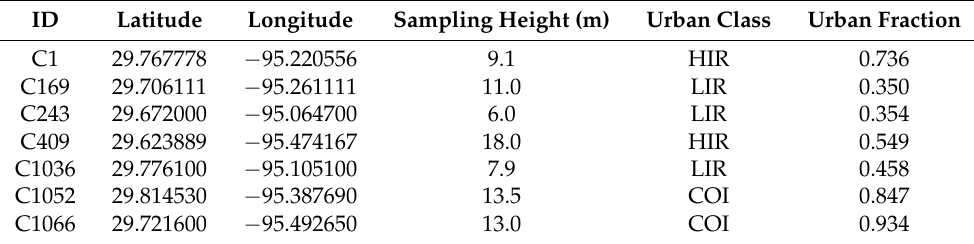
Table 2. TCEQ air monitoring sites used in